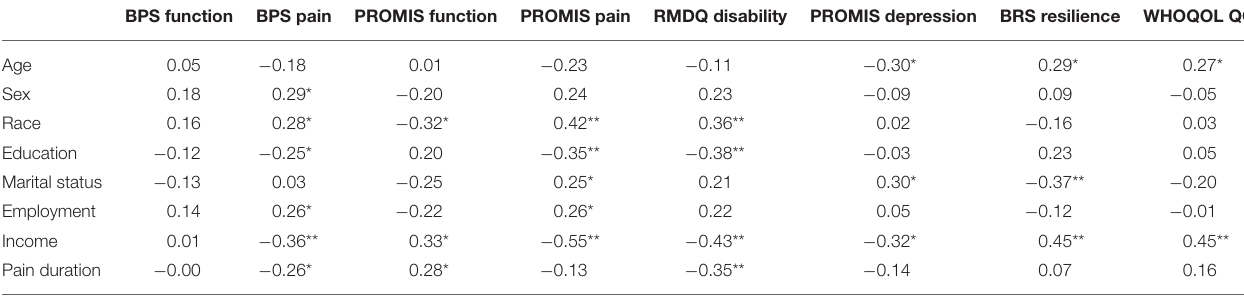
TABLE 2 | Zero-order correlations across sociodemographic characteristics and study